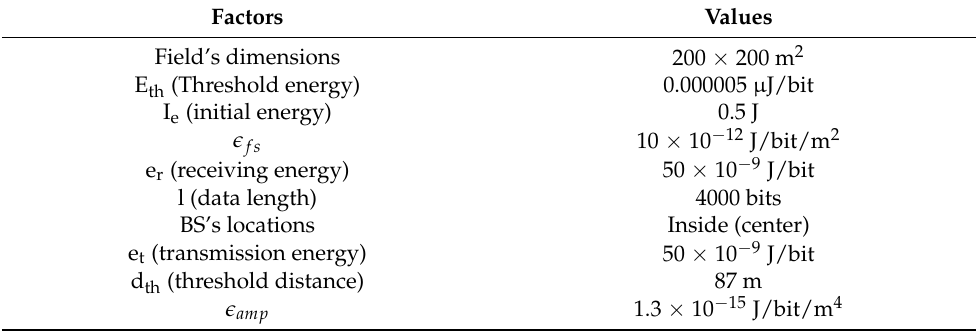
Table 1. Parameters for